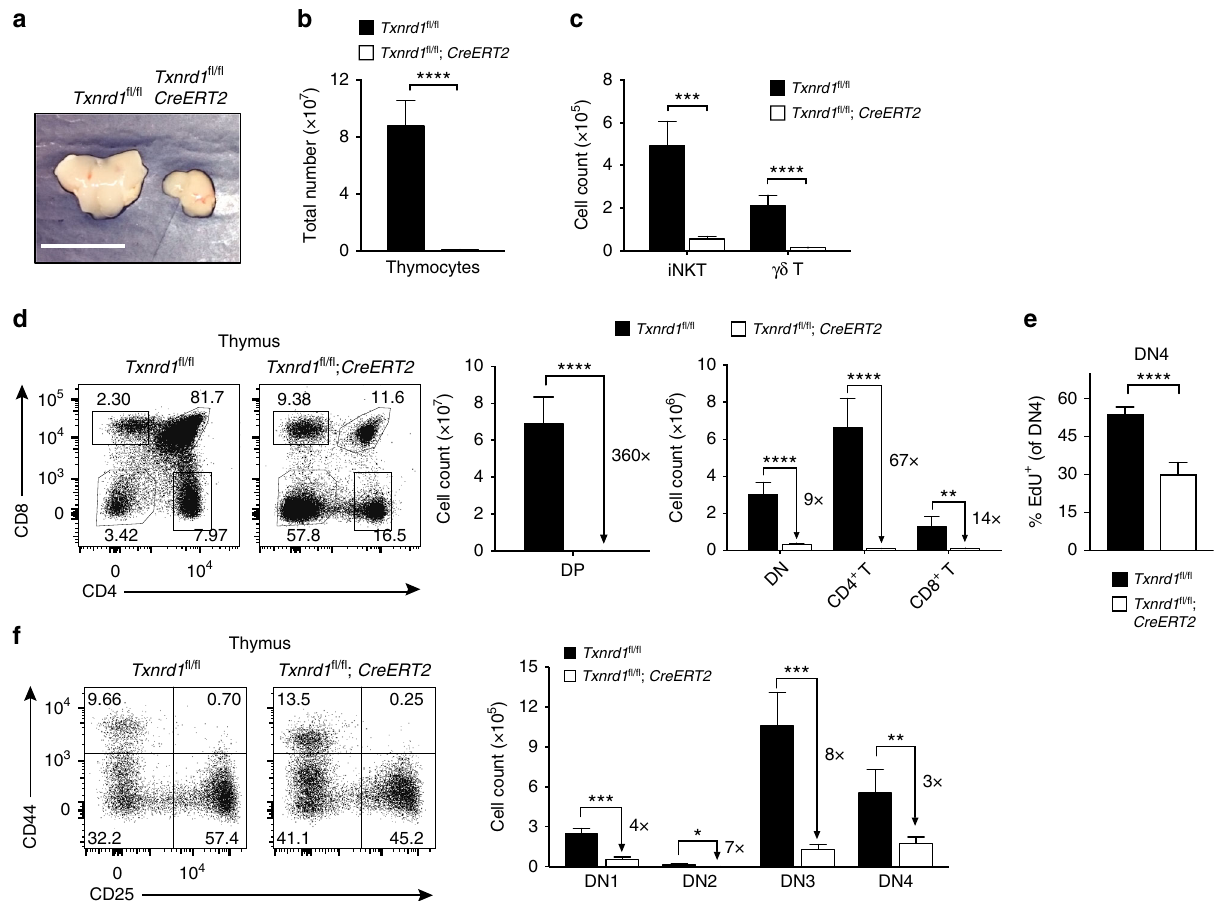
Fig. 2 Txnrd1 is critically required for thymic T-cell development. Txnrd1 fl / fl ; Cre-ERT2 mice (and Txnrd1 fl / fl littermates as controls) were analyzed by fl ow cytometry 2 weeks after TAM-mediated Txnrd1 deletion ( n = 4 – 5). a Representative image of thymi (scale bar = 1 cm). b Total number of thymocytes. c Absolute cell counts of TCR β int CD1d-PBS57-tetramer + iNKT and TCR β - TCR γδ + ( γδ T) cells in the thymus. d Representative FACS plots (left) and absolute numbers of CD4 − CD8 − DN, CD4 + CD8 + DP, CD4 + TCR β + (CD4 + T), and CD8 + TCR β + (CD8 + T) thymocytes (right). e Proliferation of DN4 thymocytes (CD25 − CD44 − ) assessed by thymic EdU incorporation. f Representative FACS plots (left) and absolute cell numbers of CD25 − CD44 + (DN1), CD25 + CD44 + (DN2), CD25 + CD44 − (DN3), and CD25 − CD44 − (DN4; right). Bar graphs show mean + standard deviation. Numbers in the bar graphs next to the arrows indicate fold-changes between Txnrd1 fl / fl and Txnrd1 fl / fl ; Cre-ERT2 groups ( d , f ). Data are representative of three ( a – d , f ) and two ( e ) independent experiments. Student ’ s t test (two-tailed, unpaired) was used to compare Txnrd1 fl / fl and Txnrd1 fl / fl ; Cre-ERT2 groups ( b – f ): * P ≤ 0.05; ** P ≤ 0.01; *** P